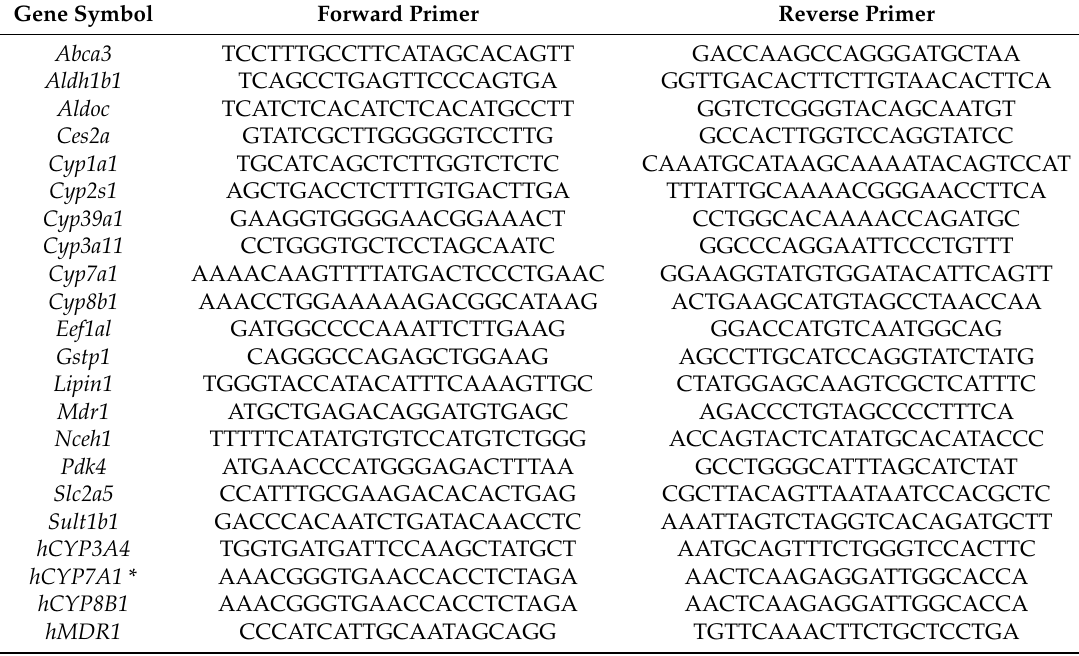
Table 1. Nucleotide sequences of primers used in quantitative